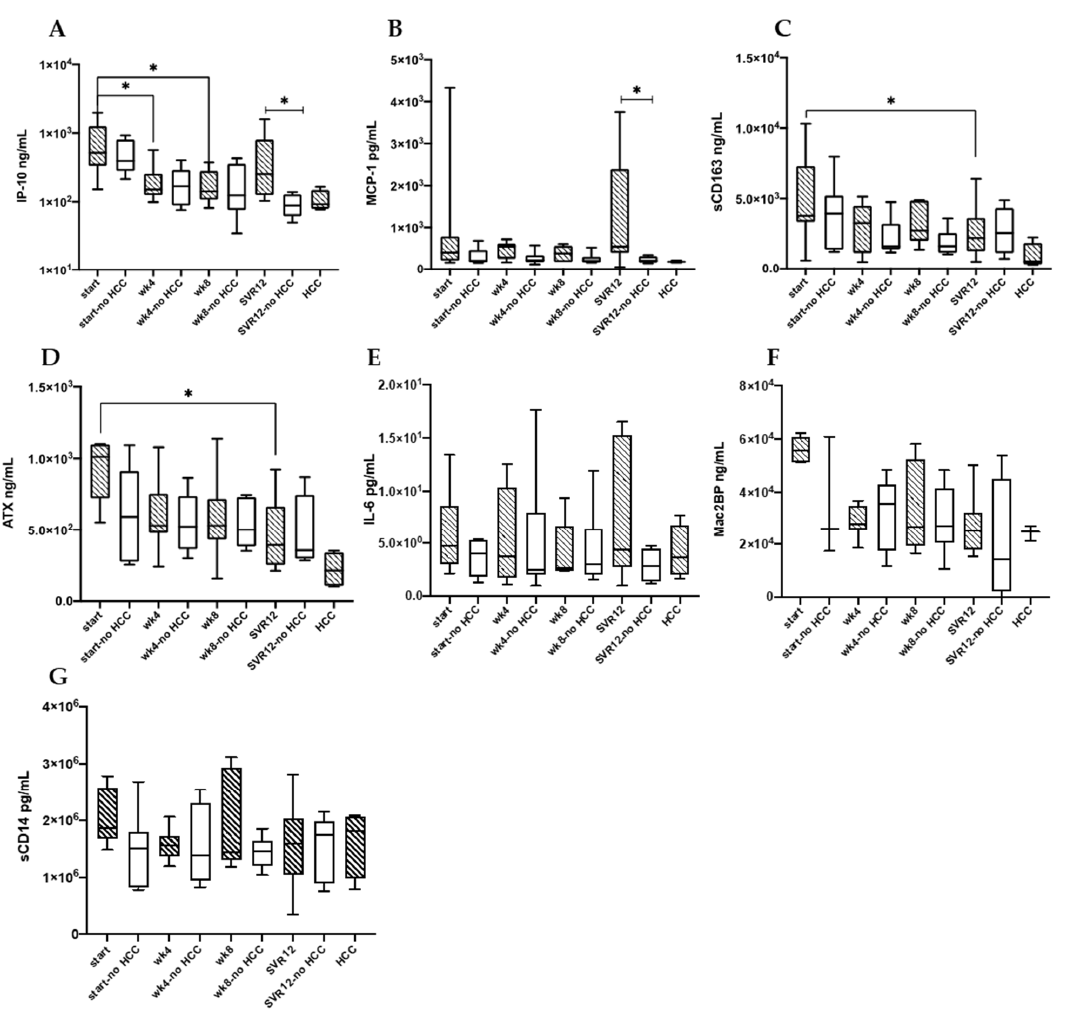
Figure 4. IP-10 ( A ), MCP-1 ( B ), sCD163 ( C ), ATX ( D ), IL-6 ( E ), Mac2BP ( F ), and sCD14 ( G ) serum levels are shown for HCC ( n = 9) and no HCC ( n = 7) groups at the beginning of DAA therapy (start and start no HCC indicating DAA therapy start for HCC and no HCC groups), through therapy